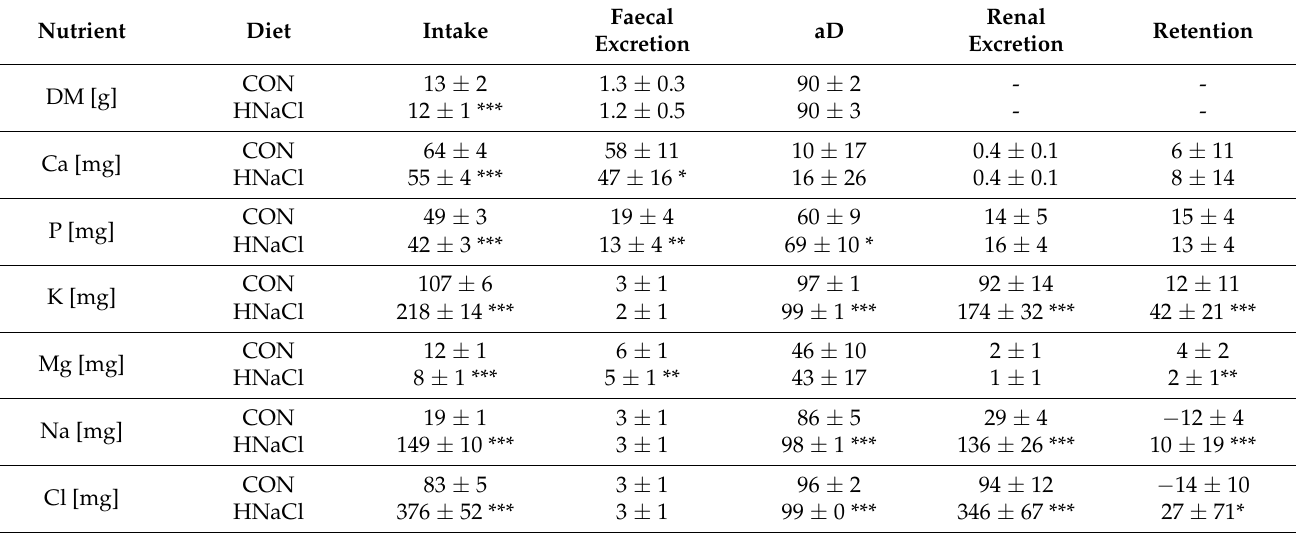
Table 2. Intake, renal and faecal excretion, retention per kg body weight and day, and apparent digestibility [%] of dry matter and minerals (mean ± standard